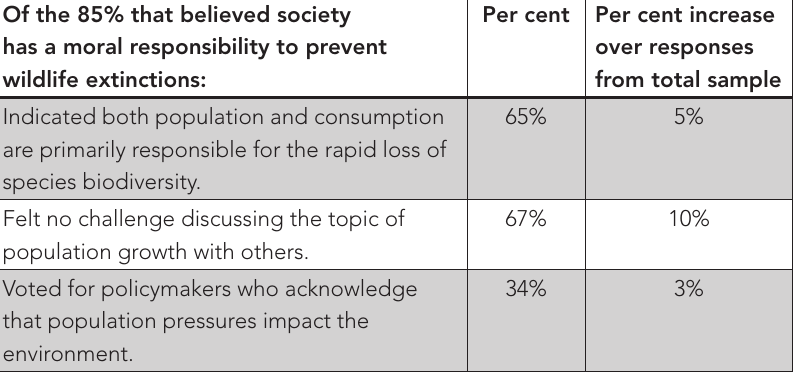
Per cent Per cent increase over responses from total sample 65% 5% 67% 10%